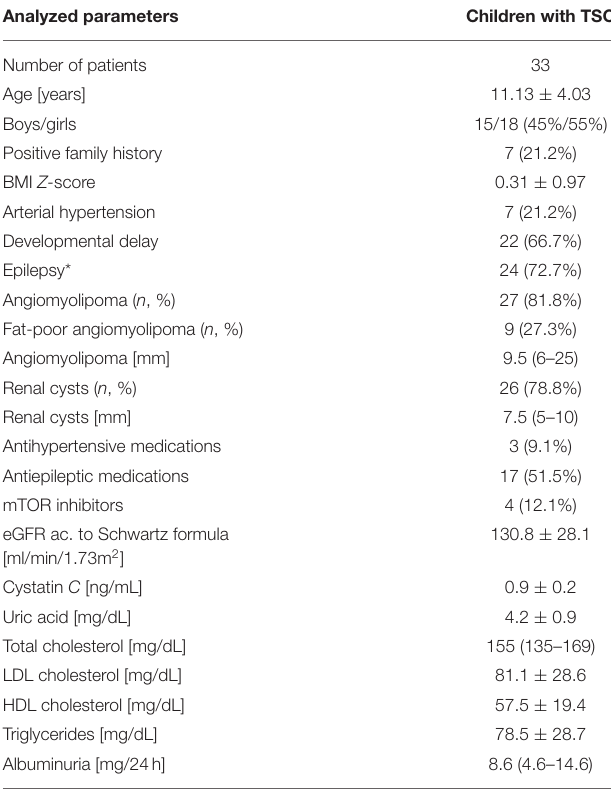
TABLE 1 | Clinical and biochemical parameters in children with tuberous sclerosis complex. Analyzed